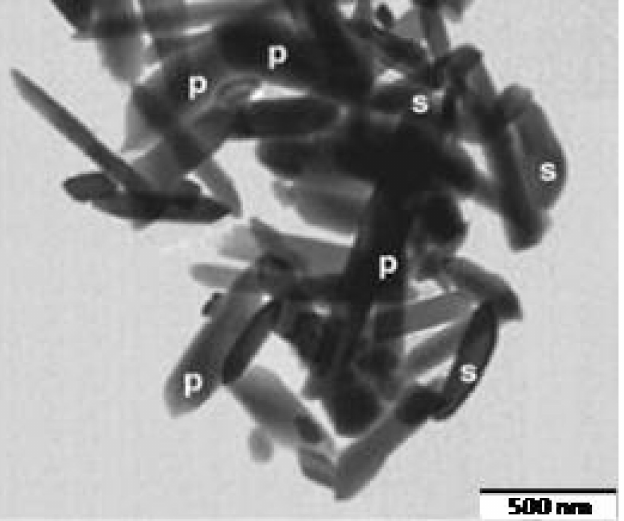
Figure 5. TEM image of the mullite crystals developed at 1450 ◦ C in porous mullite blocks from Bayer alumina waste and kaolin (p and s denotes primary and secondary mullite, respectively) [95].